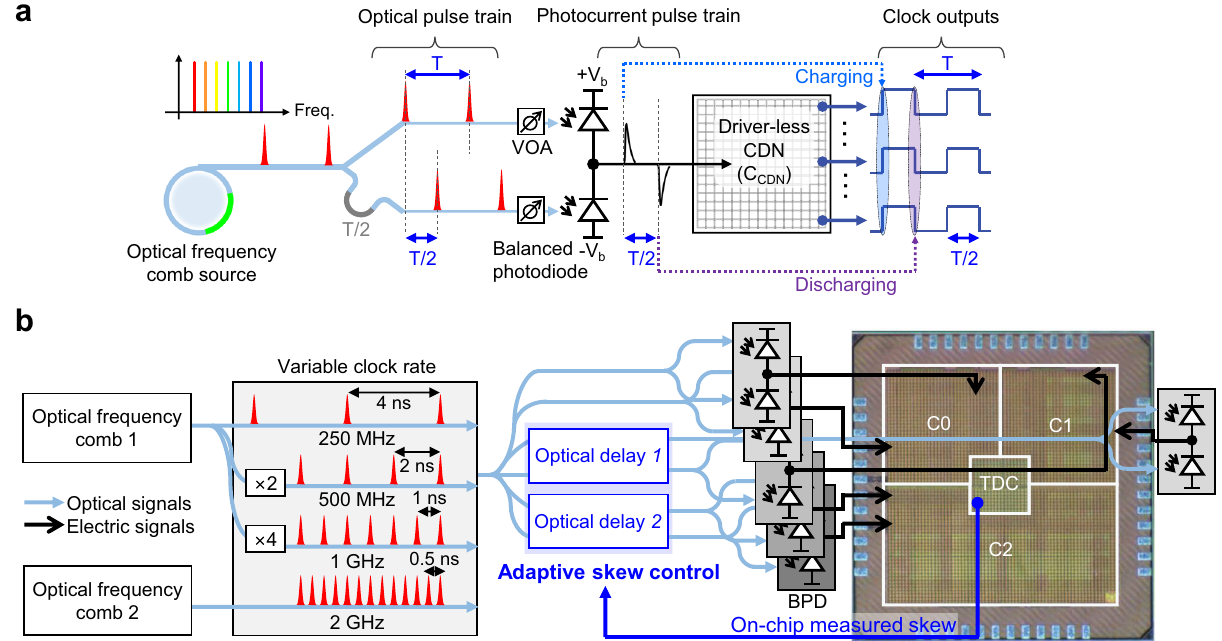
Fig. 1 | Photonic CDN with an optical frequency comb as a master clock. a Conceptual schematic diagram of the demonstrated photonic CDN. VOA Variable optical attenuator. b Schematic of the photonic CDN demonstration experiment. BPD Balanced photodiode, TDC Time-to-digital converter.